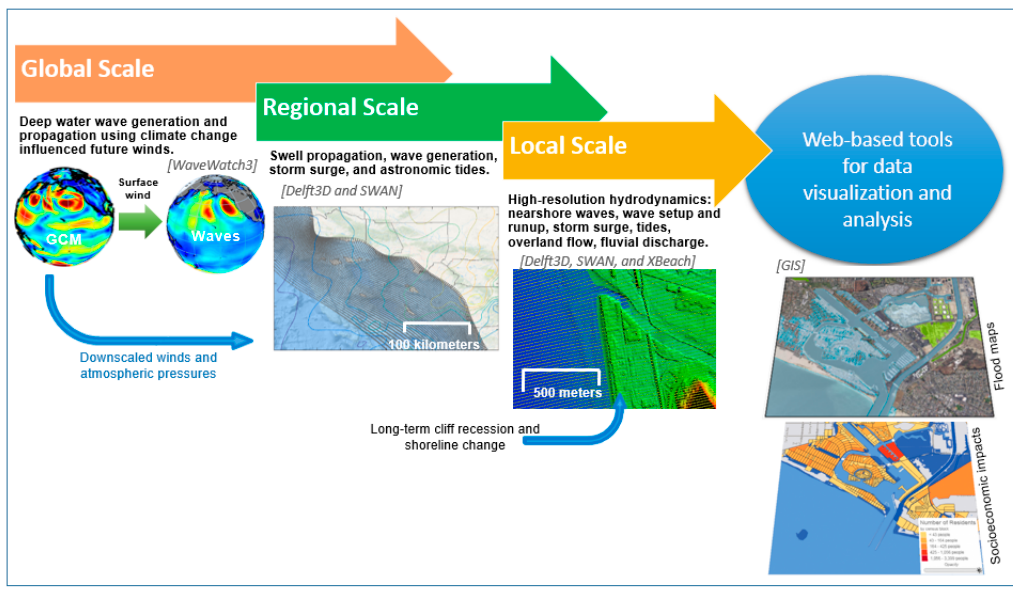
Figure 2. CoSMoS model system overview. Models and tools used in each step are shown with gray text. GIS-enabled web-tools for data visualization are detailed in Part 2 [17].